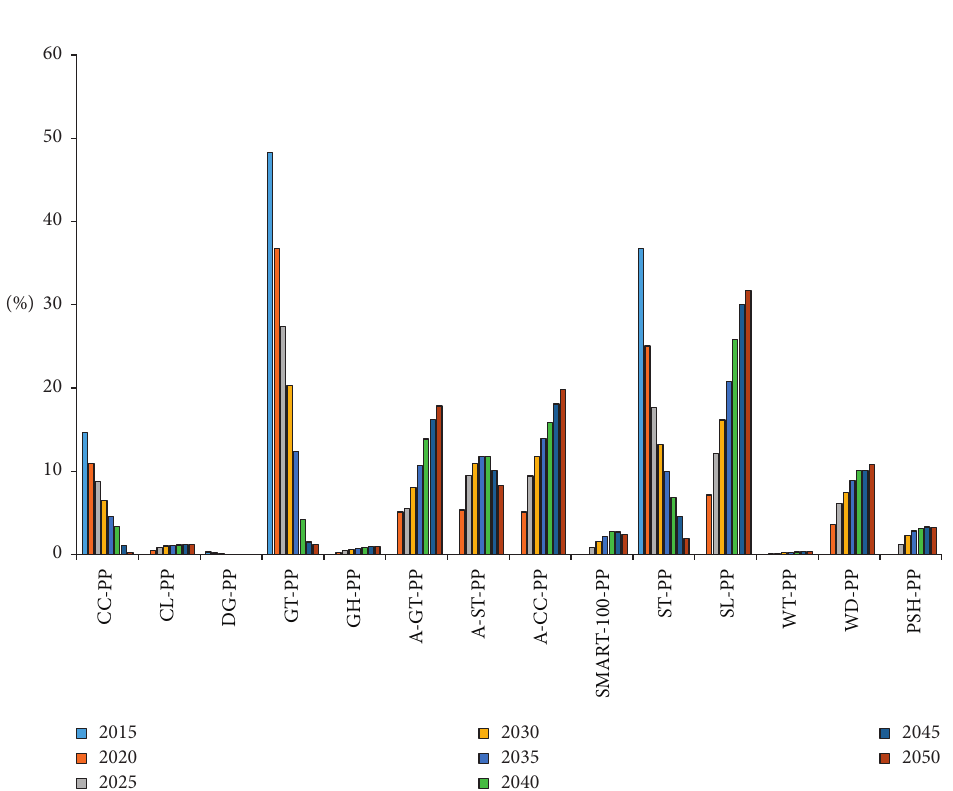
Figure 11: Share of power plant technologies for Subscenario